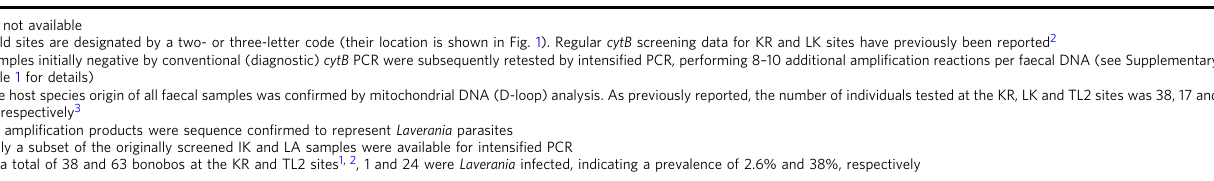
Table 1 for details) c Thehost species originof allfaecal sampleswas con fi rmed by mitochondrial DNA (D-loop)analysis. As previously reported, the numberof individualstested at the KR,LK and TL2sites was 38, 17 and 63, respectively 3 Of a total of 38 and 63 bonobos at the KR and TL2 sites 1, 2 , 1 and 24 were Laverania infected, indicating a prevalence of 2.6% and 38%,